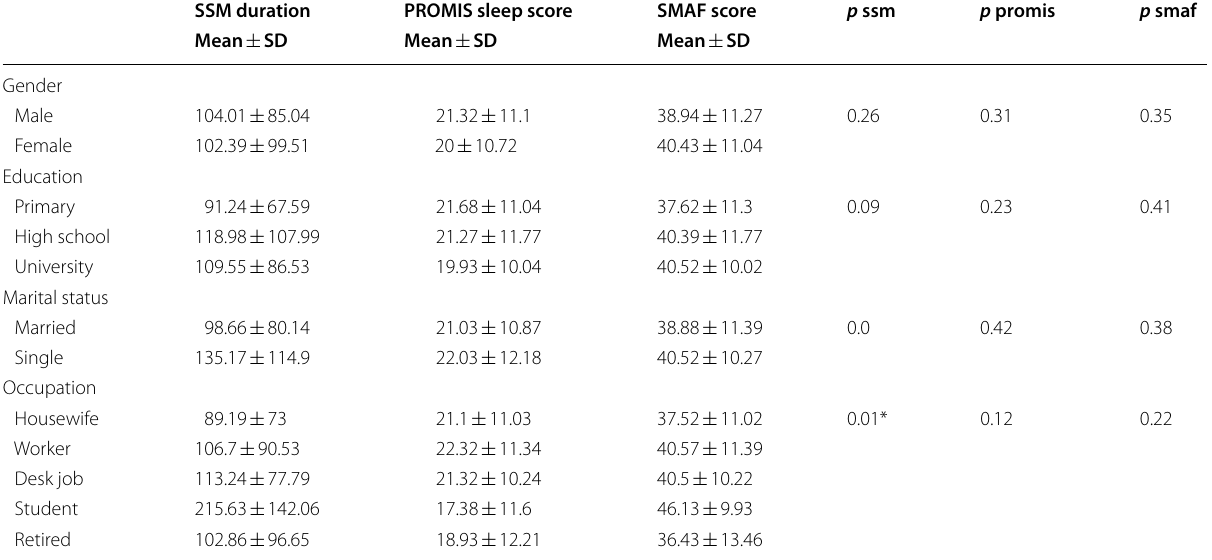
Table 6 Analysis of the relationship between SSM duration, PROMIS sleep score, SMAF score and patient characteristics in the FMS group